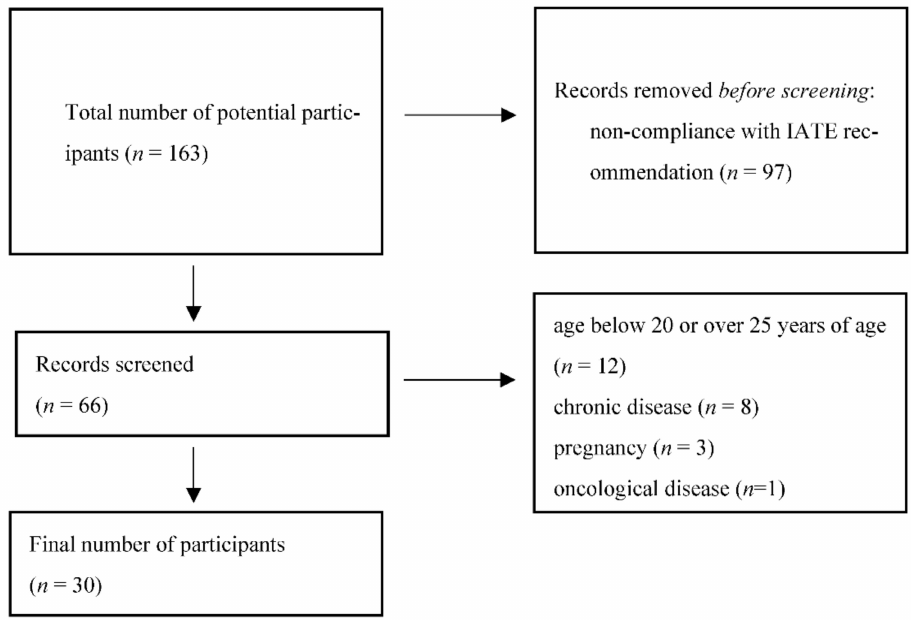
Figure 1. The procedure for selecting participants’ medical records that were finally